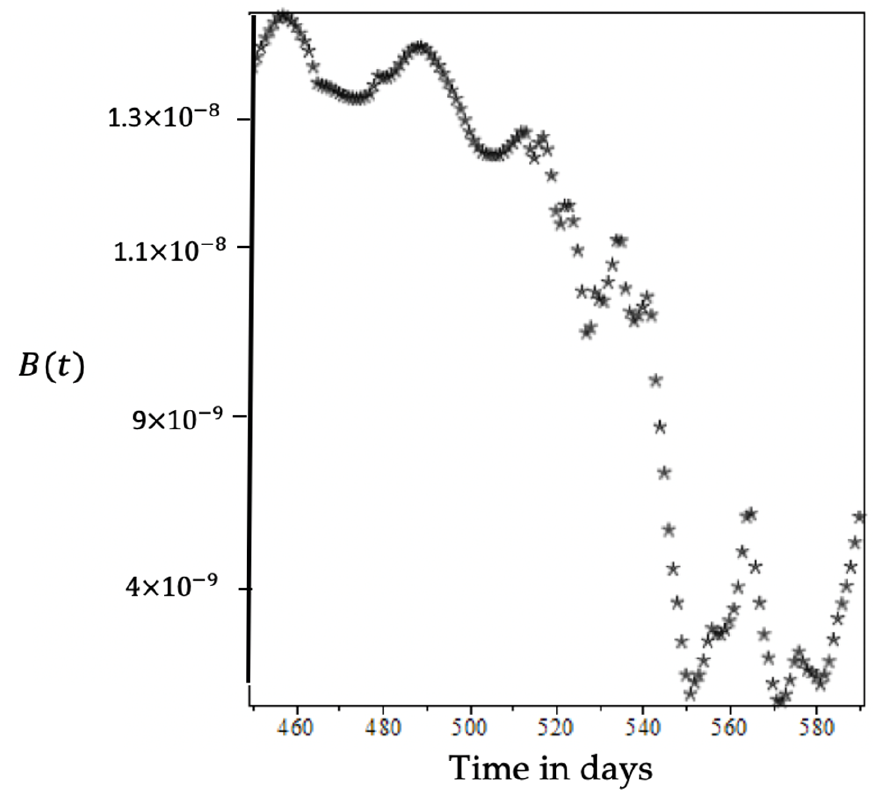
Figure 5. Time development of the transmission rate of the symptomatic population, 450 ≤ 𝑡 < 600 .